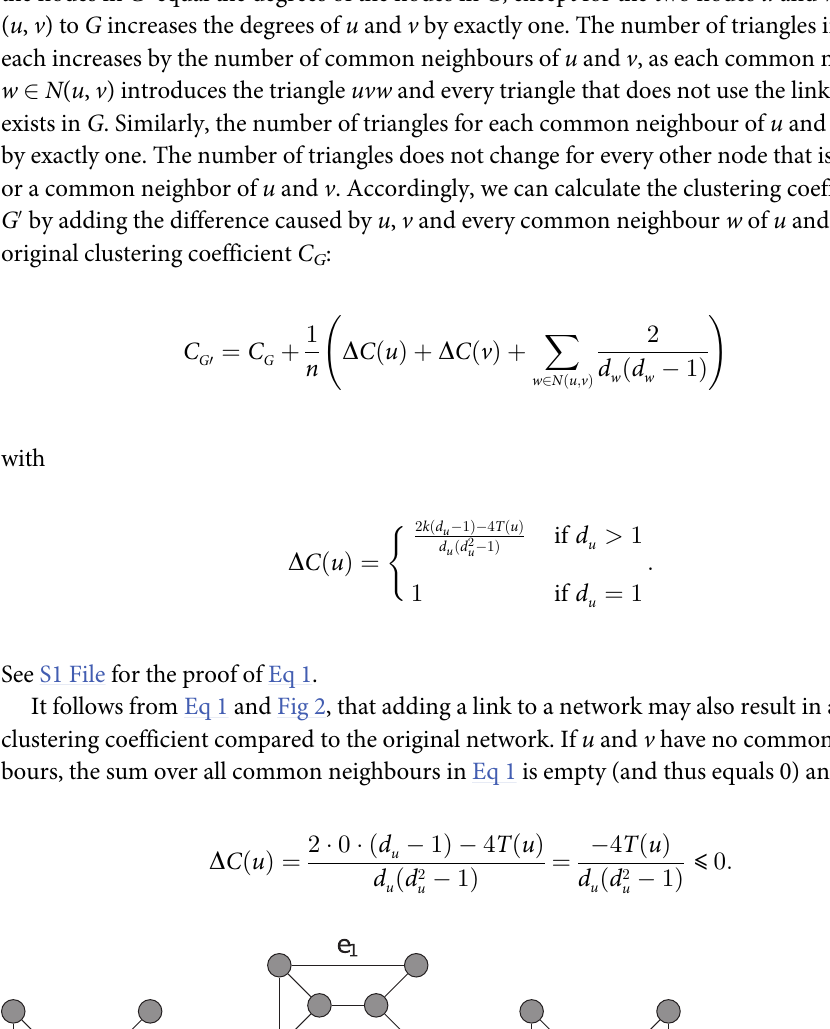
¼ 0 : 2�7 G þ e 1